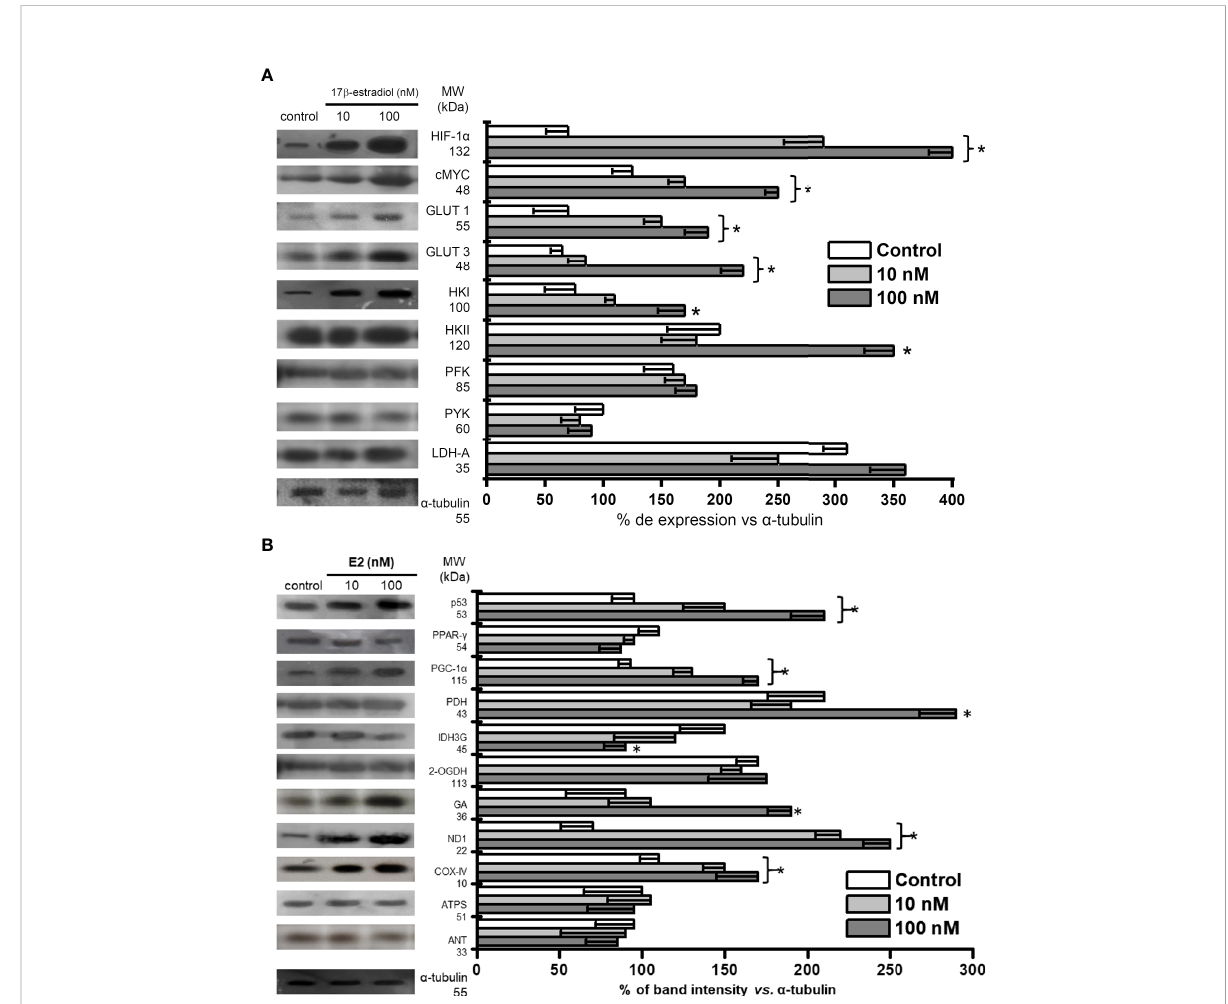
FIGURE 3 Effect of E2 on the contents of (A) transcription regulators and protein contents involved in glycolysis pathway; (B) transcription regulators and protein contents involved in OxPhos pathway of MCF-7 MCTS. Histograms represent a double normalization against a -tubulin. Data shown represent the mean ± S.D. of at least three different preparations. * P <0.05 vs. control (non-treated cells). The numerical values on the left y-axis indicate the respective molecular